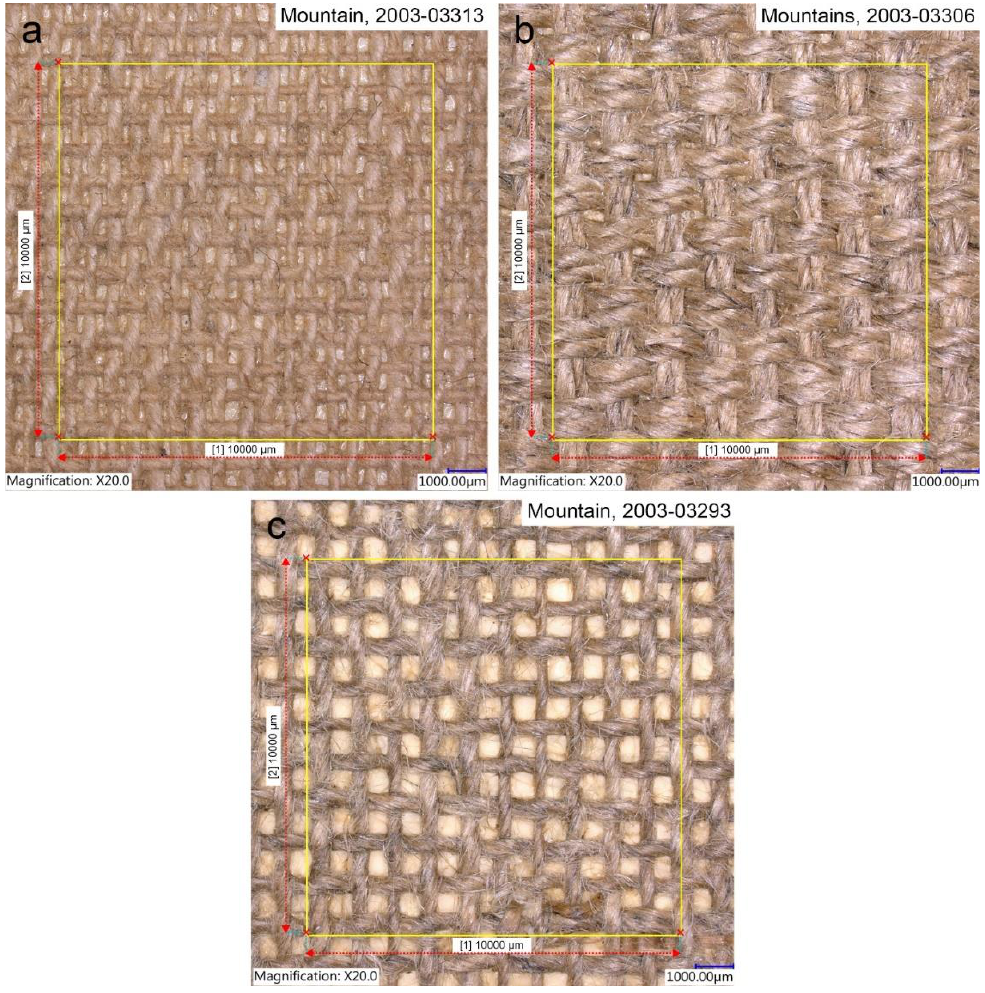
Figure 3. Details of the photomicrographs of three types of canvases identified in the investigated paintings: ( a ) type 1; ( b ) type 2; ( c ) type 3.